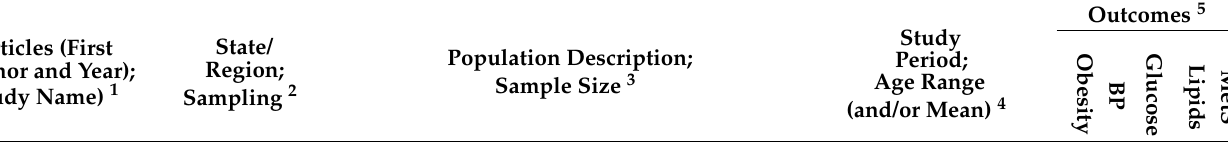
Table 1. Summary of included studies and